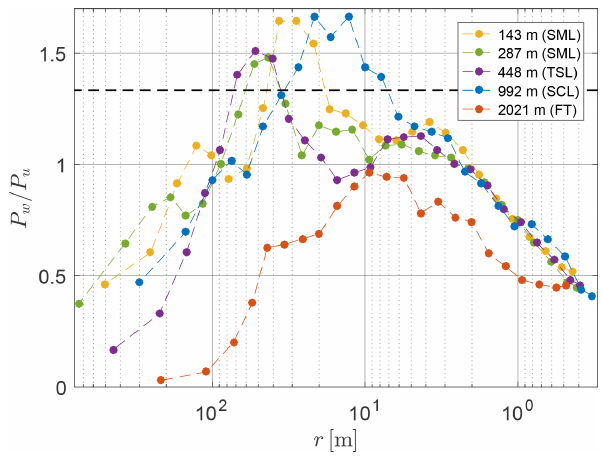
Figure 18. As in Fig. 17 but for the decoupled STBL (flight no.